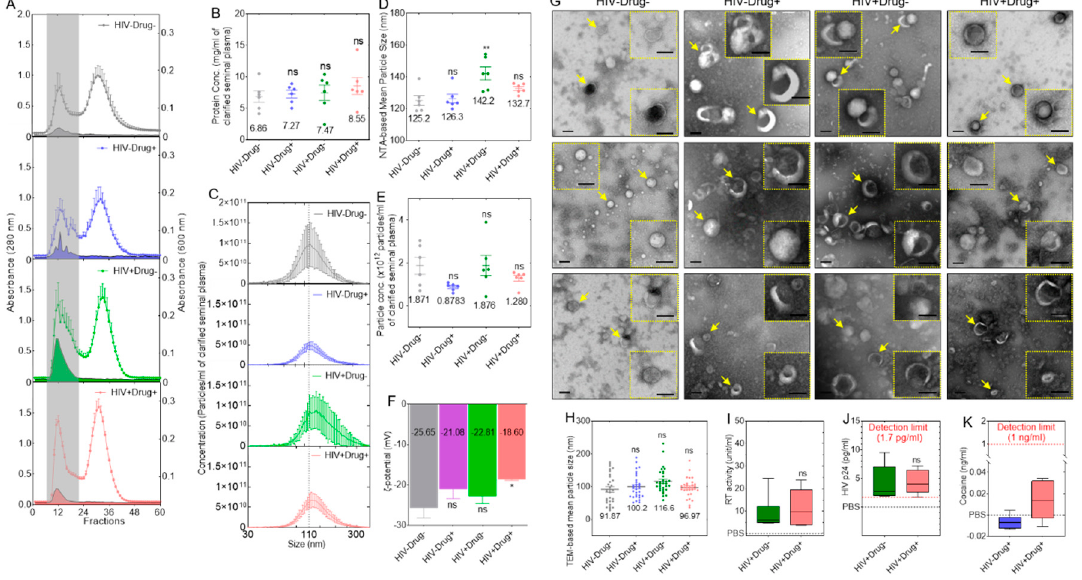
Figure 1. Physical characterization of semen exosomes (SE) from di ff erent clinical groups: ( A ) Exosomes were isolated from semen specimens obtained from donors in di ff erent clinical groups—HIV − Drug − , HIV − Drug + , HIV + Drug − , and HIV + Drug + . Seminal plasma from di ff erent participants were pooled, and the exosomes were purified by size exclusion chromatography (SEC). Six pools of clarified seminal plasma (n = 2, 100 µ L / donor) from each of the four clinical groups were purified by size exclusion chromatography (SEC), and fractions were collected. UV–Vis was used to monitor absorbance at 280 nm and turbidity at 600 nm, indicative of the presence of proteins and lipid-containing vesicles, respectively. The dotted curve and filled curve represent absorbance profiles at 280 nm (protein) and 600 nm (lipid), respectively. The gray vertical rectangle highlights exosome fraction. ( B ) Purified SE fractions were pooled, and total protein concentration was determined by Bradford assay. Nano Tracking Analysis (NTA) measurements of the di ff erent SE physical properties: ( C ) size distribution profile, ( D ) NTA-based particle mean size, ( E ) mean particle concentration, and ( F ) Mean zeta potential ( ζ -potential, mV). ( G ) Negative-stain TEM images of purified SE from the four clinical groups: The insets correspond to zoomed areas indicated by the arrow. All scale bars = 100 nm. ( H ) TEM-based mean particle size from Figure 1G determined with Image J. Assessment of HIV proteins: ( I ) HIV reverse transcriptase (RT) and ( J ) HIV p24. A total of 30 µ g purified SE (~6 × 10 9 particles) from HIV + groups (6 pools of 2 donors each) were tested in triplicate. An equivalent volume of PBS was used as the negative control. ( K ) Cocaine metabolite ELISA. A total of 30 µ g purified SE (~6 × 10 9 particles) from Drug + groups (6 pools of 2 donors each) were tested in triplicate. Equivalent volume of Phosphate Bu ff ered Saline (PBS) was used as a negative control. The numbers in the graphs of Figure 1B,D–F,H indicate mean values. Error bars indicate SEM of 6 biological replicates. For a two-group comparison, unpaired t-test with Welch’s correction was used to determine the di ff erences between the groups. For a four-group comparison, ordinary one-way ANOVA test (Dunnett’s correction) was used to determine the di ff erences between the SE groups as compared to HIV − Drug − . * p < 0.05, ** p < 0.01, and ns,